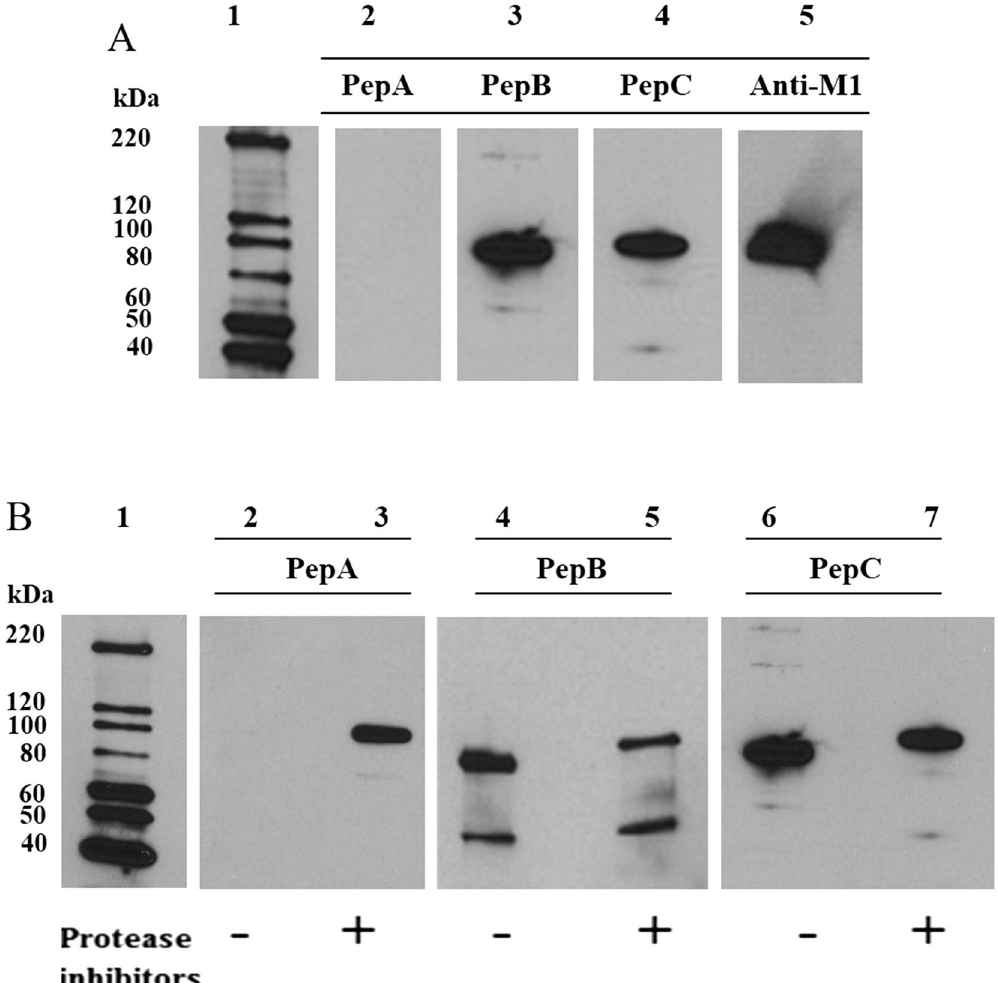
Figure 3. Immunoblots with peptide antibodies. ( A ) Recombinant Pf M1AAP was probed with antibodies prepared against 14-mer peptides derived from the N-terminal extension (PepA), spanning domain 1 (PepB) and domain 4 (PepC) (see Supplementary Fig. 1). Anti- Pf M1AAP was used as a positive control. Anti-PepA does not react with r Pf M1AAP, as this lacks the N-terminal extention, whereas both anti-PepB and anti-PepC do. Lane 1 was loaded with chemilluminescent molecular marker. Lanes 2–5 were loaded with 0.25 µg of recombinant M1. ( B ) Cytosolic fractions of malaria parasites prepared without (−) and with (+) a